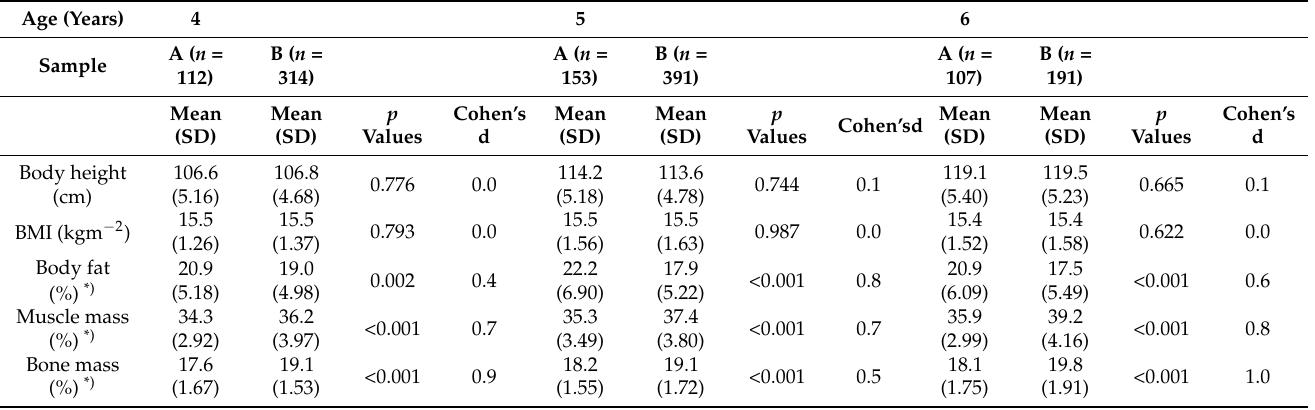
Table 2. Comparison of monitored somatic traits in present Czech preschool children aged 4–6 years with sample 1990—girls. Age